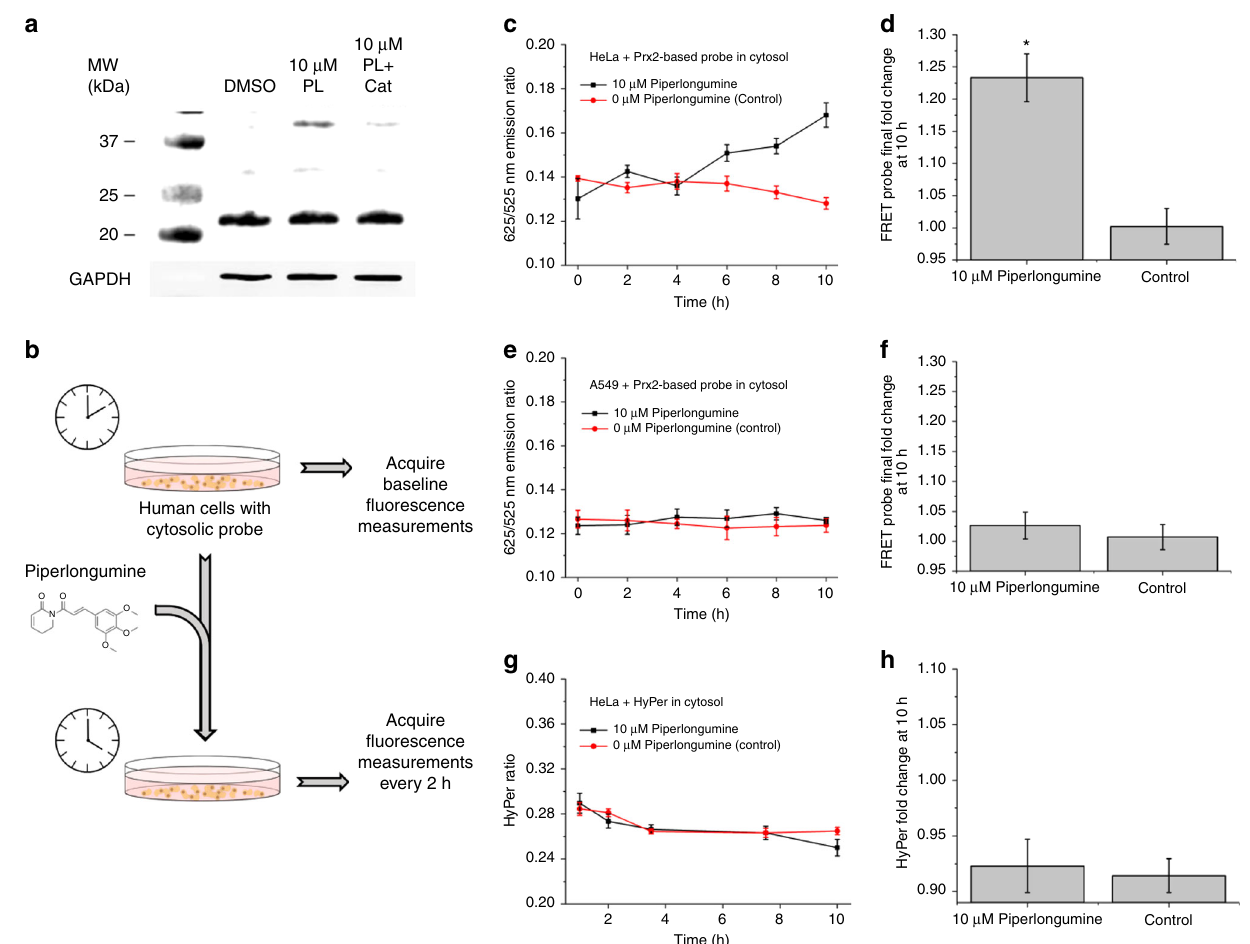
Fig. 6 Response of Prx2-based probe and HyPer to the redox therapeutic compound piperlongumine (PL). a Human Prx2 in monomeric and dimeric form upon exposure to 10 μ M piperlongumine, solubilized using dimethyl sulfoxide (DMSO), or an equivalent volume of DMSO without the drug. Endogenous glyceraldehyde 3-phosphate dehydrogenase (GAPDH) was simultaneously analyzed in these blots to assess the uniformity of lysate loading and protein content. b Schematic representation of piperlongumine experiment. c 625/525nm emission ratio as a function of time in HeLa cells expressing the FRET probe upon incubation with either 10 μ M piperlongumine in DMSO (black line), or an equivalent volume of DMSO (red line) over the course of 10 h in a total volume of 2.5 mL. d Emission ratio fold change at 10 h for the two different conditions. e 625/525nm emission ratio as a function of time in A549 cells expressing the FRET probe upon incubation with either 10 μ M piperlongumine in DMSO (black line), or an equivalent volume of DMSO (red line) over the course of 10 h in a total volume of 2.5 mL. f Emission ratio fold change at 10 h for the two different conditions. g HyPer ratio as a function of time from HeLa cells expressing HyPer upon incubation with either 10 μ M piperlongumine in DMSO (black line), or an equivalent volume of DMSO (red line) over the course of 10 h in a total volume of 2.5 mL. Data points represent mean ratio ± S.E.M. for nine cells and re fl ect three biological replicates. h HyPer ratio fold change at 10 h for the two different conditions. Data points for time course experiments represent mean ratio ± S.E.M. for nine cells and re fl ect three biological replicates. Data points for fold change plots represent mean fold change ± S.E.M. for 27 cells and re fl ect three biological replicates. Bar graphs plus dot plots shown in Supplementary Fig. 23. * p < 0.02; two-tailed student ’ s t